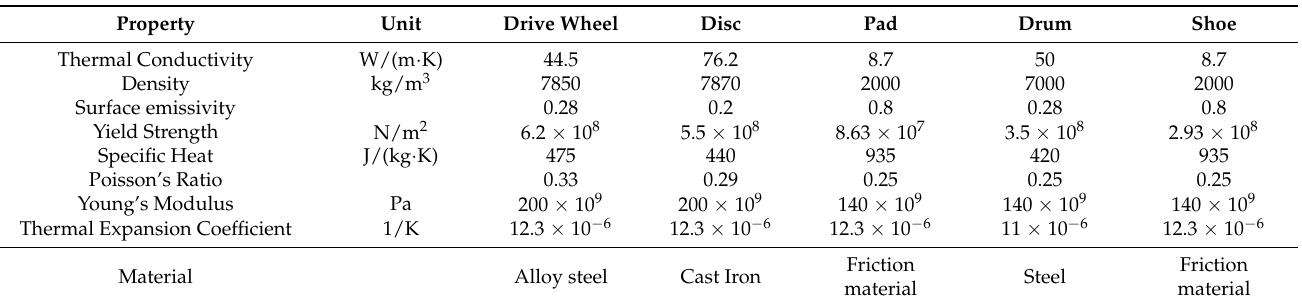
Table 1. Material properties for the brake elements.